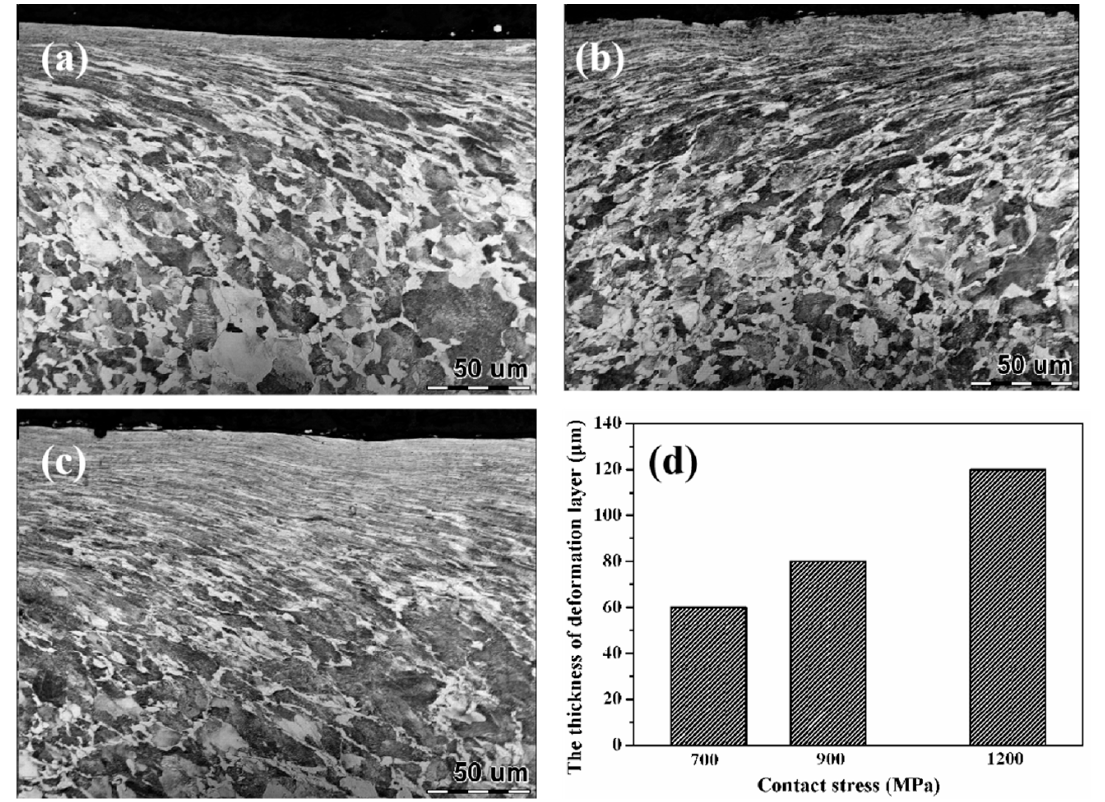
Figure 7. The optical microscope (OM) micrographs of wheel samples under different contact stress conditions ( a ) 700 MPa; ( b ) 900MPa; ( c ) 1200MPa and ( d ) the thickness of the plastic deformation layer.